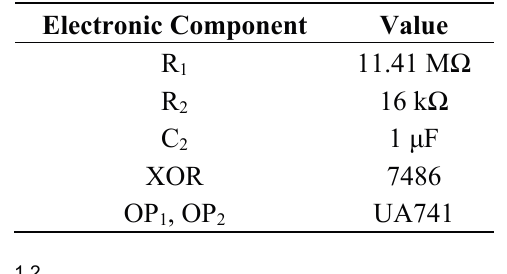
Table 3. Values of the electronic components used.